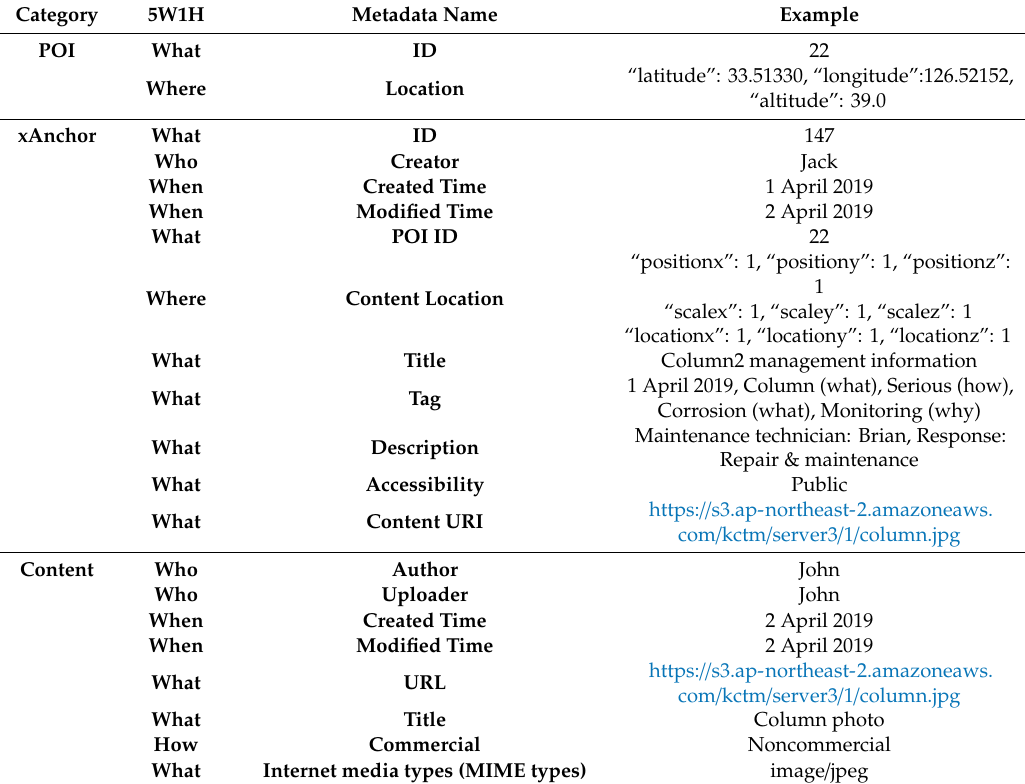
Table 1. Example of POI-xAnchor-content metadata in a geo-tagged content authoring